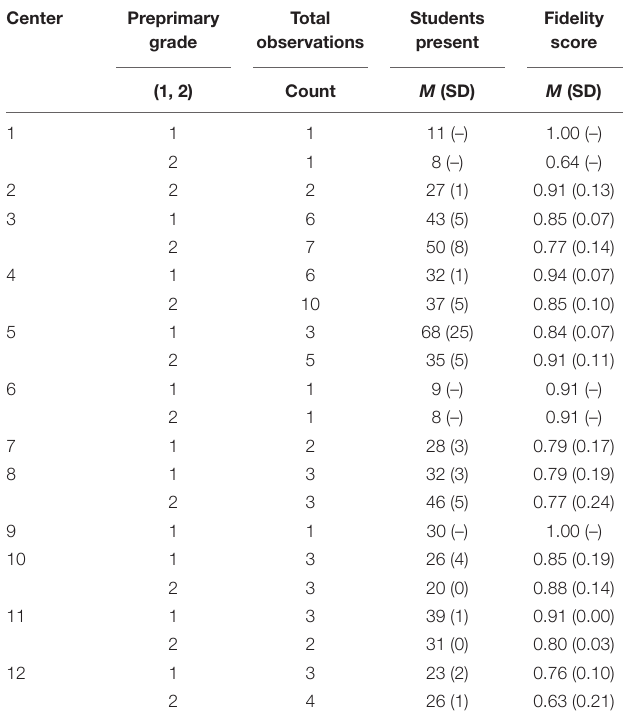
TABLE 2 | Classroom level information from fidelity observations. Center